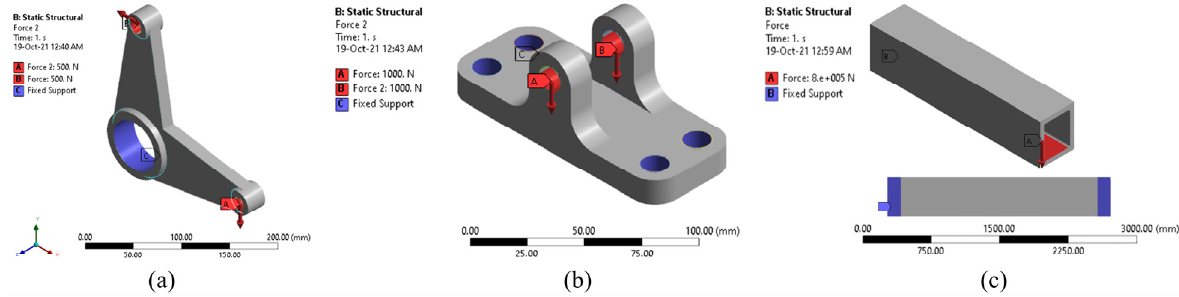
Figure 4. The three case studies: ( a ) bell crank lever, ( b ) pillow bracket, and ( c ) small bridge.